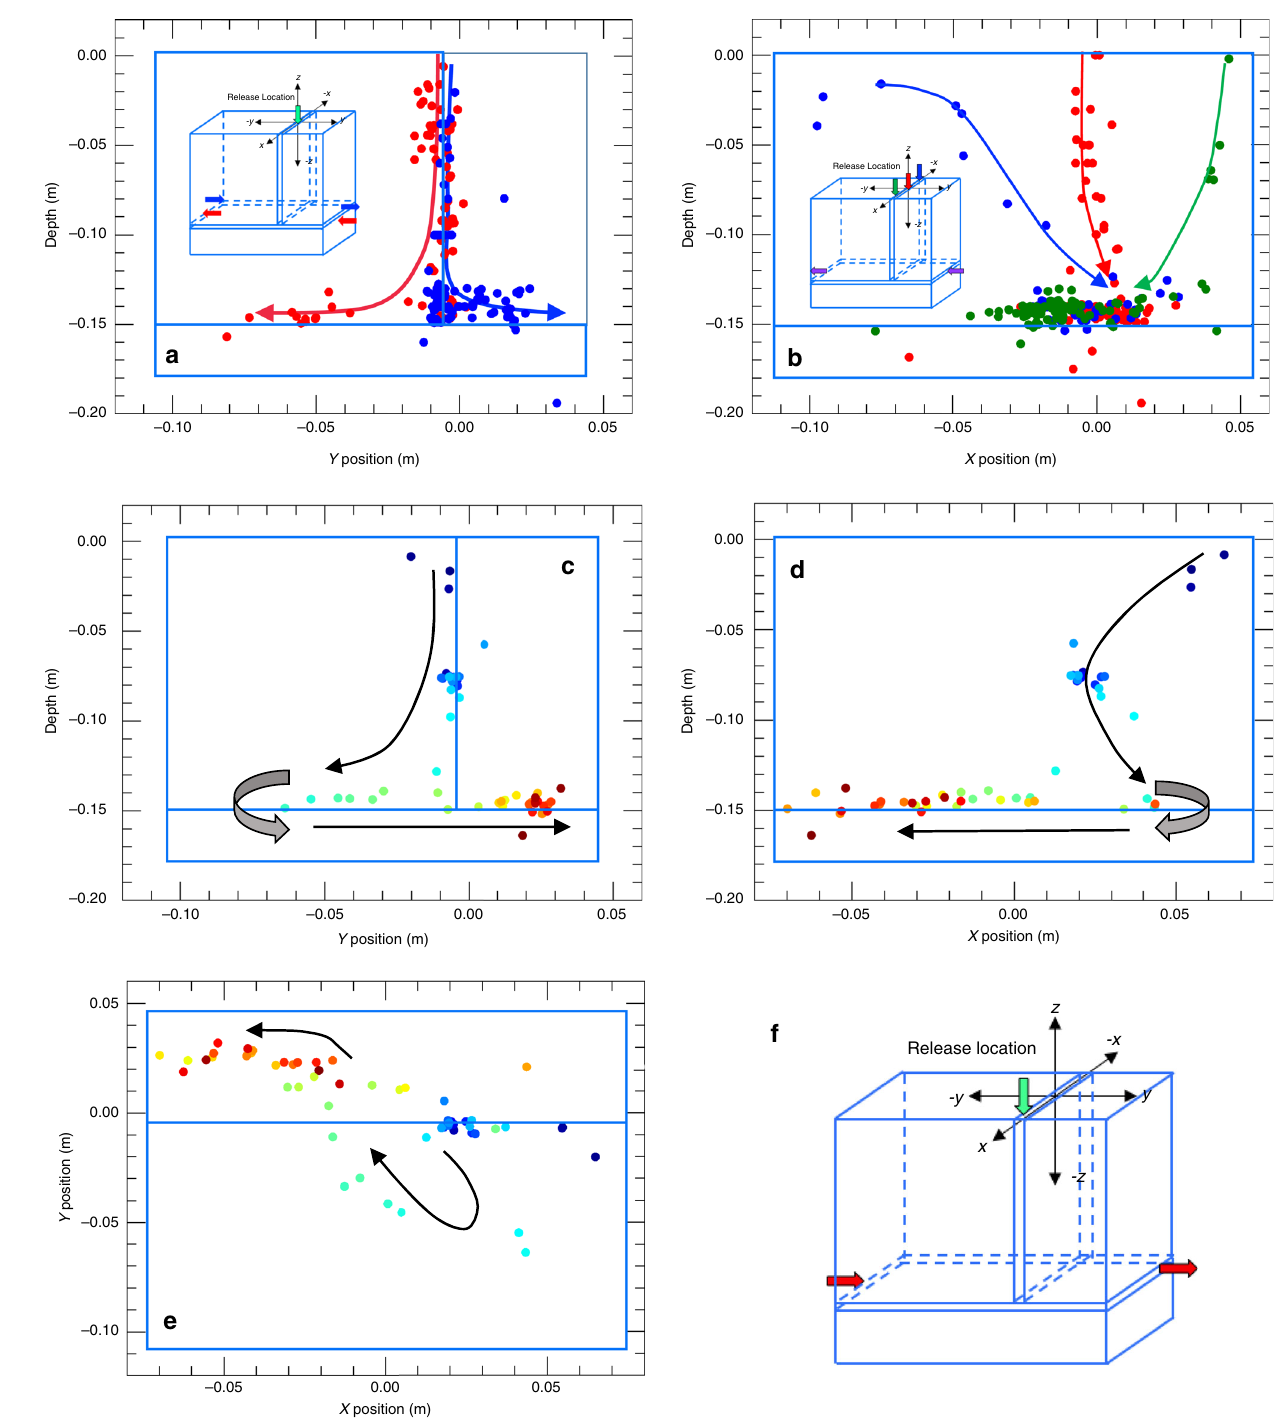
Fig. 7 Tracking streamlines in intersecting fractures. Flow through an inverted T fracture intersection for: a dust z – y location as a function of horizontal location during fl ow to the right (blue) and to the left (red), b y – x location for different release locations during fl ow to the left, and c – e complex fl ow paths as chattering dust is transported through the vertical fracture and into the horizontal fracture, which was subjected to fl ow from left to right (color of symbols represents early time (blue) to later time (red)). The release location of the dust for c – e is indicated by the green arrow in f , and the red arrows show the inlet and outlet locations for the fl